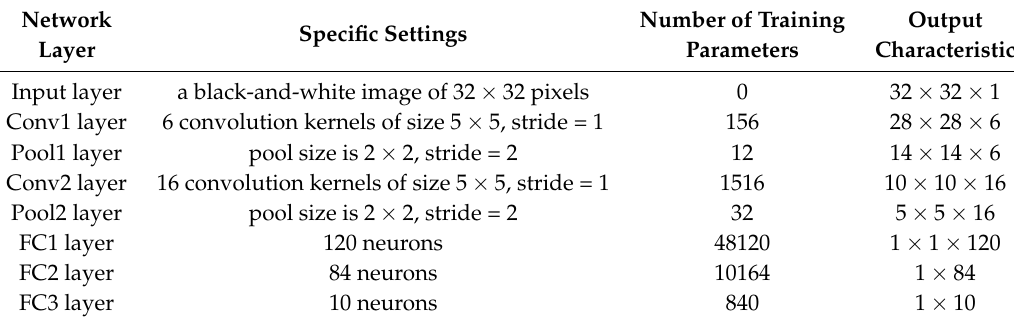
Table 1. Detailed settings of traditional LeNet-5 network